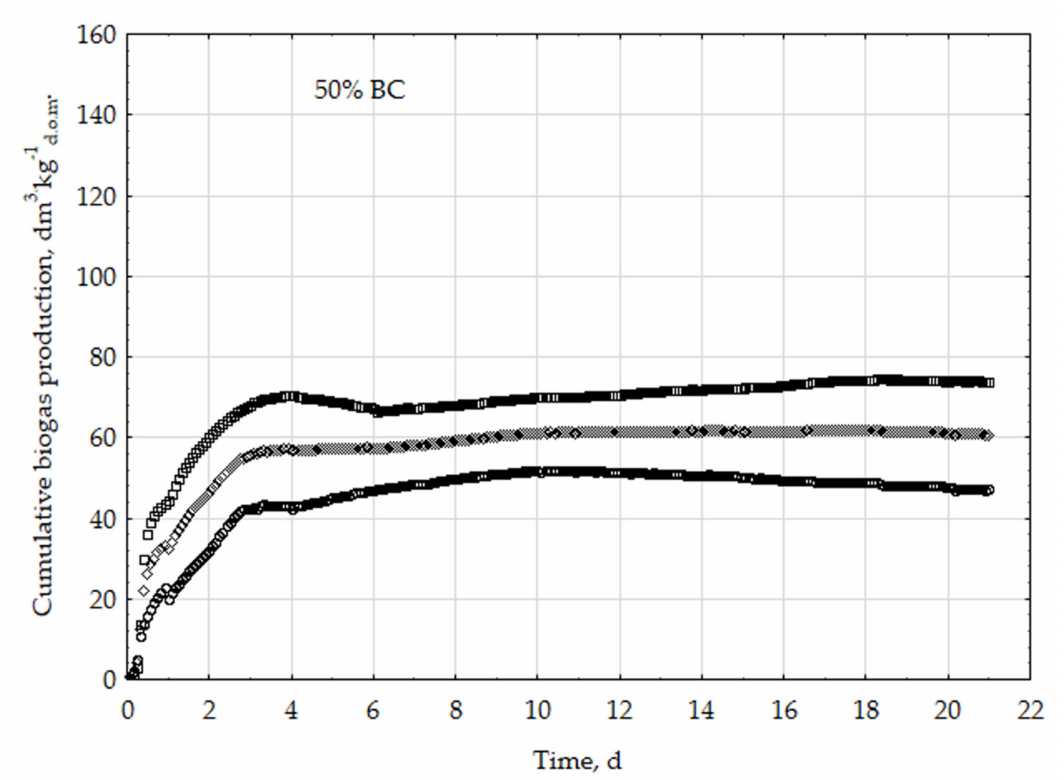
Figure A9. Biogas production from BSG: cumulative curves in variant with biochar addition at the level of 50%. The number of repetitions was